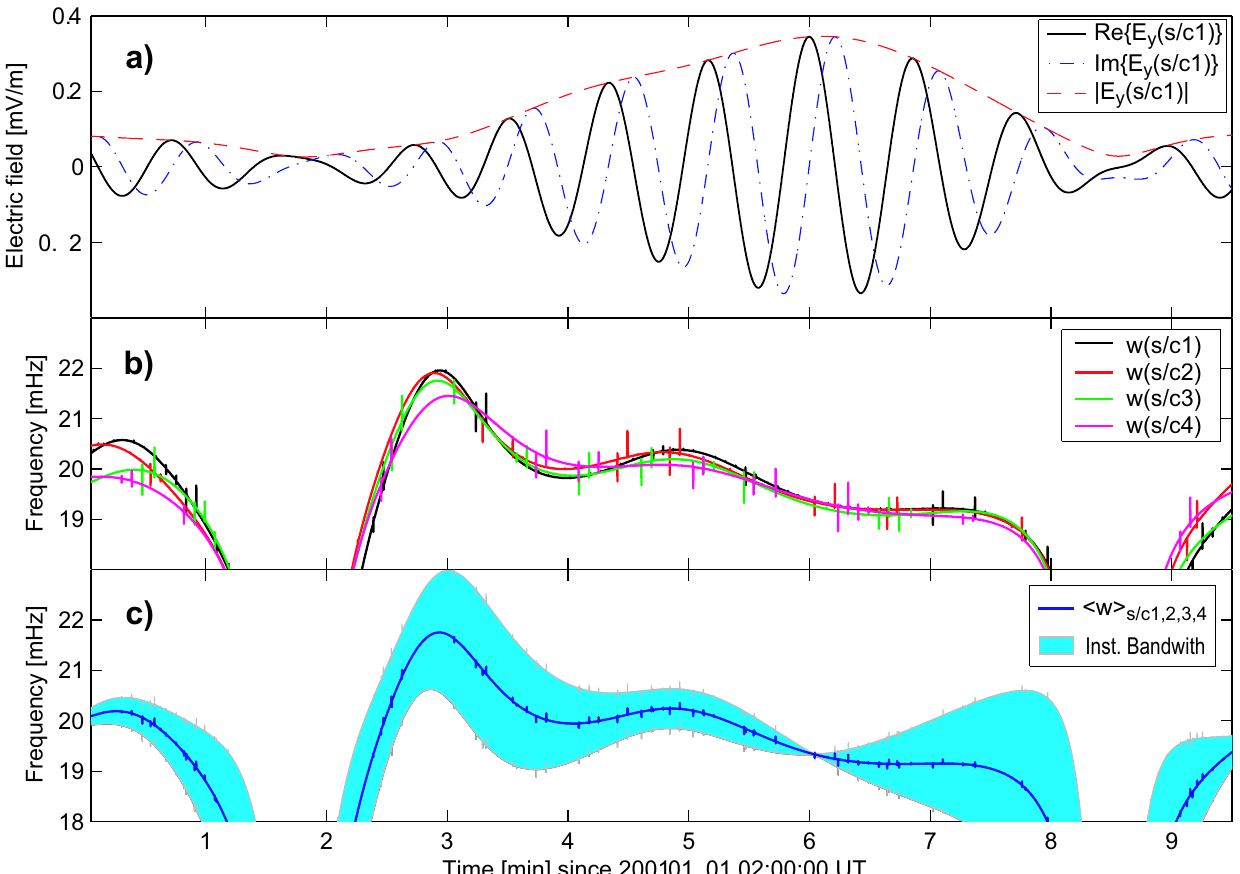
Fig. 2. A quasi-monochromatic wave observed over 10min in the solar wind analysed using the instantaneous local wave analysis technique. The analysis starts from a real measured quantity, in this case the GSE Y-component of the electric field, Re { E y } , shown as a solid black curve in (a) . The measured field is then Hilbert transformed to create the quadrature component Im { E y } shown as a dot-dashed blue curve in (a). Taken together ( Re { E y } , Im { E y } ) = E y , that is they make up the complex analytical signal of the electric field component and from which one calculates the envelope (amplitude) shown as a dashed red curve in (a). The phases are also calculated and their rate of change is the instantaneous local frequency w(t, s / c ) shown as the four (one colour per spacecraft) overlayed curves in (b) . The average frequency for the Cluster quadruple, h w i , is shown as a dark blue curve in (c) . The analysis also provides an instantaneous bandwidth for the frequency estimate shown as a light shading region around the centre frequency curve in c). The bandwidth is useful for establishing the accuracy of h w i . Among other things, the analysis reveals that the wave exhibits a weak, but detectable, modulation in frequency around